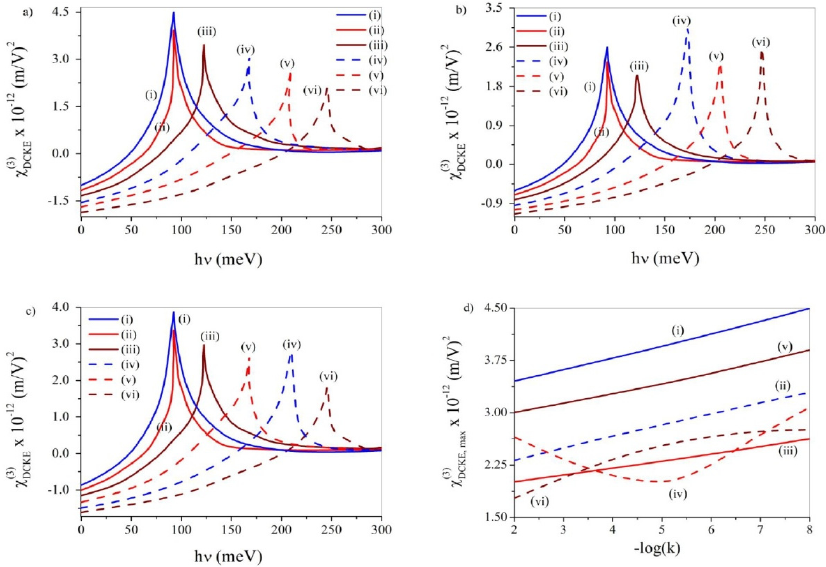
Figure 13. DCKE vs. h υ diagrams ( a ) devoid of noise, ( b ) under ADWN and ( c ) under MLWN. In these diagrams the anharmonicity has (i) odd parity and k = 10 − 8 , (ii) odd parity and k = 10 − 5 , (iii) odd parity and k = 10 − 2 , (iv) even parity and k = 10 − 8 , (v) even parity and k = 10 − 5 , (vi) even parity and k = 10 − 2 . ( d ) Depiction of DCKE peak values vs. − log(k): (i) devoid of noise and OPA, (ii) devoid of noise and EPA, (iii) with ADWN and OPA, (iv) with ADWN and EPA, (v) with MLWN and OPA and (vi) with MLWN and EPA.